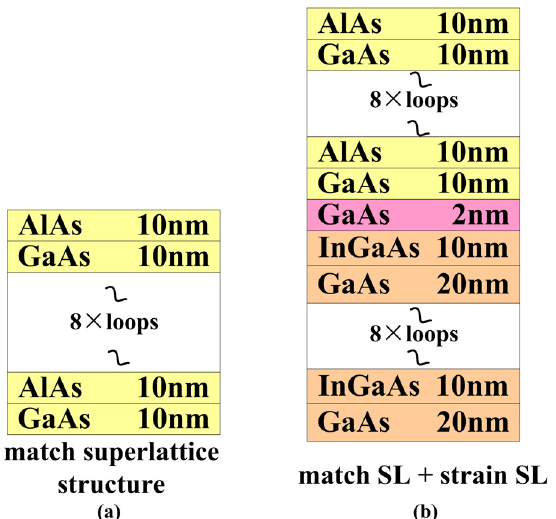
Figure 1. Two different optimization